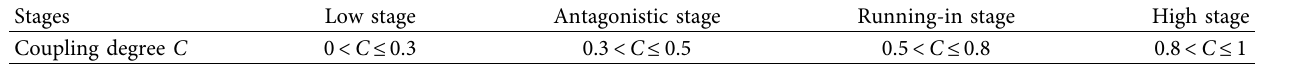
Table 2: Stages of coupling degree.